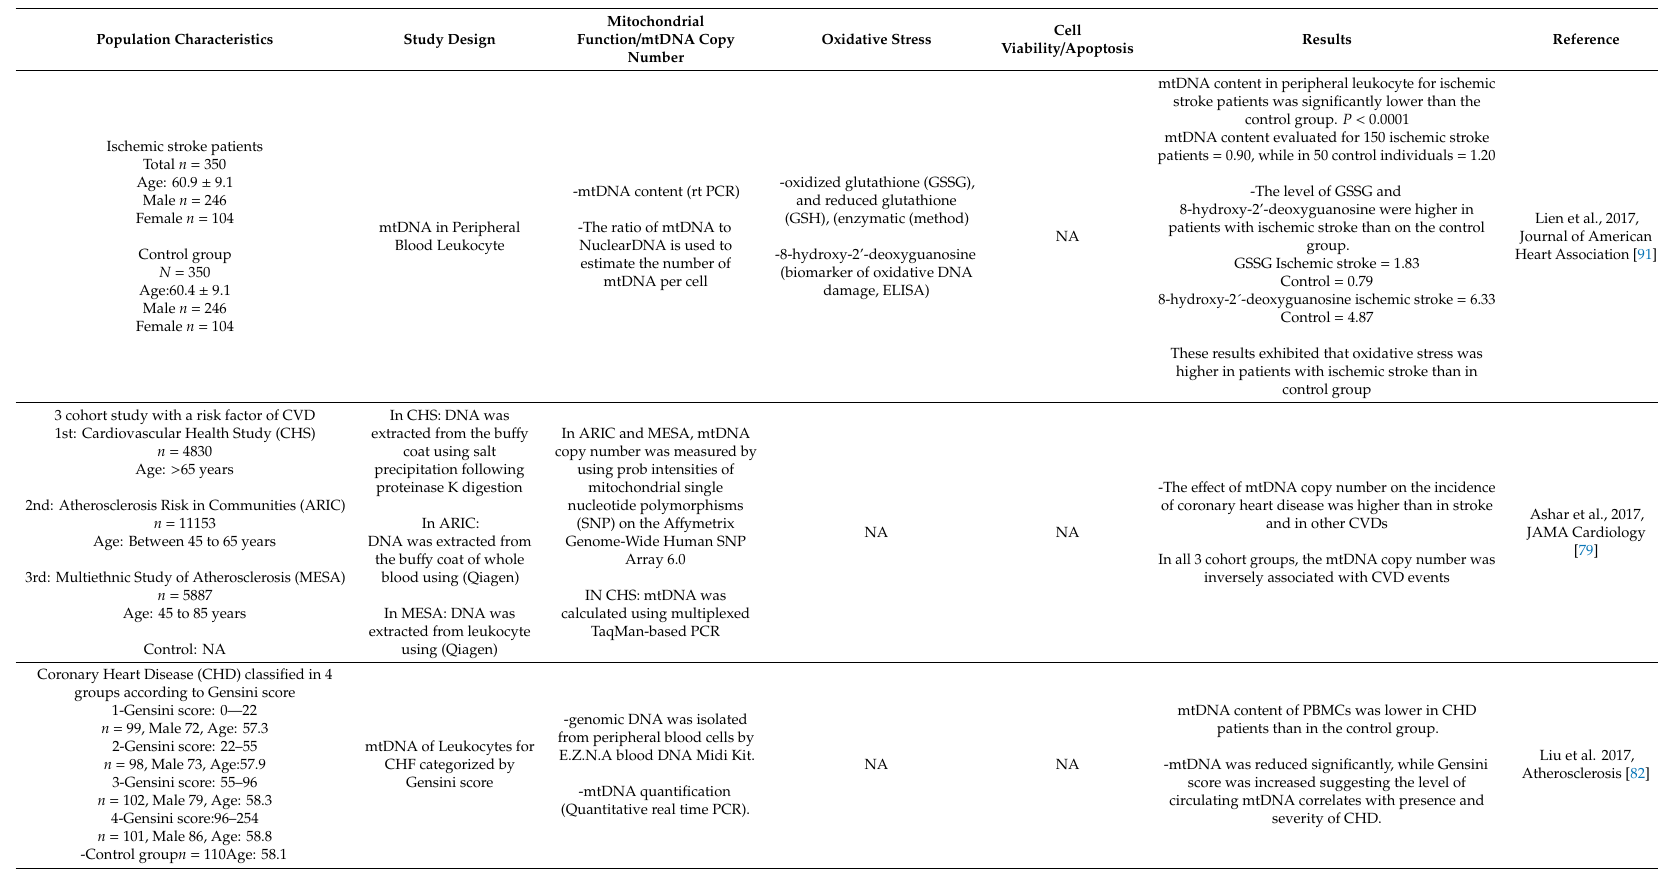
Table 2. Mitochondrial DNA in peripheral circulating cells and cardiovascular